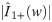
Validation of Eq (66) along the real axis w, by substituting η = −k cos w.Left: absolute value of |I^1+(w)| (exact = thick solid gray line, approximate = solid black line). Right: relative error in log10 scale obtained from the approximate expression of I1+(η) for η = −k cos w given by Eq (66) while substituting the exact expression of V1+(η), performing the numerical integration and considering the full properties of V1+(pn(η)) in w plane. Test cases are relative to different sets of parameters: Φa,=0.7π,0.4π,0.18¯π, Φb = 1.2π, φo = 0.1π. We recall that −π < w < 0 is the portion of real axis of w plane in the proper sheet of η plane.